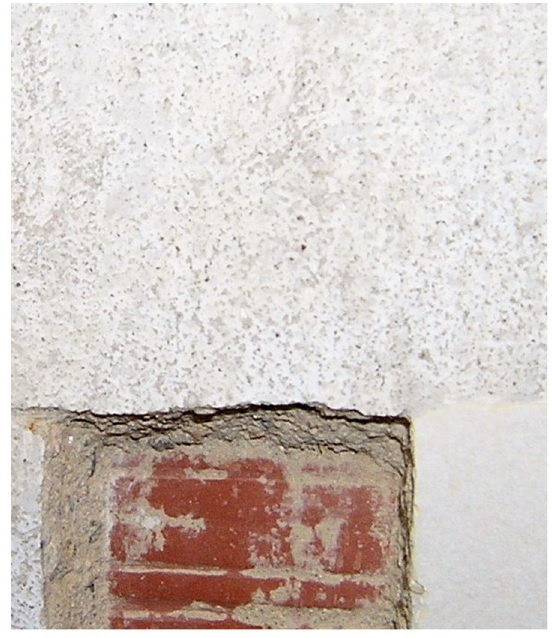
Fig. 12 Pavel Janák, Brno, fair grounds, pavilion of the Prague School of Applied Arts, 1928, original facade plaster: the surface rubbed, with thin, bright fresco-lime wash, similar to the later one at the house Tugendhat (Source: study work HAWK / Hildesheim, Ivo Hammer, Silke Heinemann and Jan G. Menath, 2005)